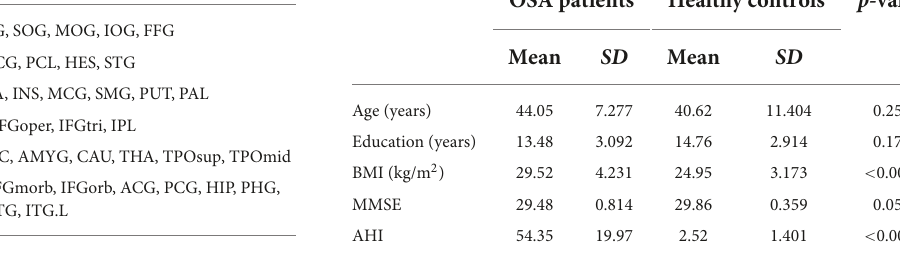
TABLE 2 The demographic and clinical characteristics of patients with OSA and healthy controls. OSA patients